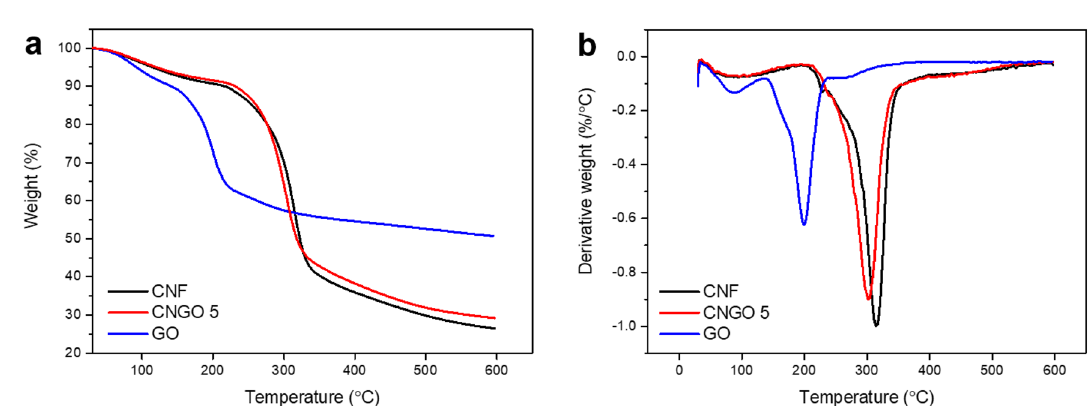
Figure 6. Thermal properties of the pristine CNF, CNGO 5, and GO: ( a ) TGA and ( b )